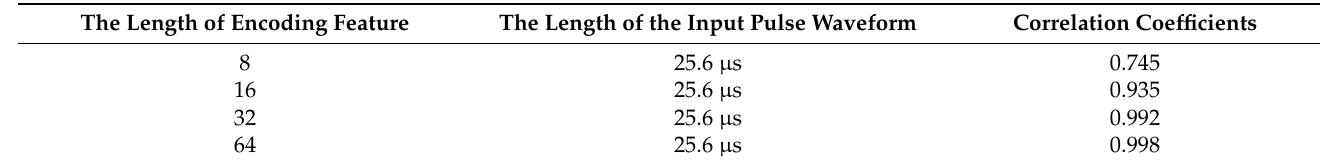
Table 1. The correlation coefficients between the original waveform and the waveform decoded by different lengths of the encoding feature.